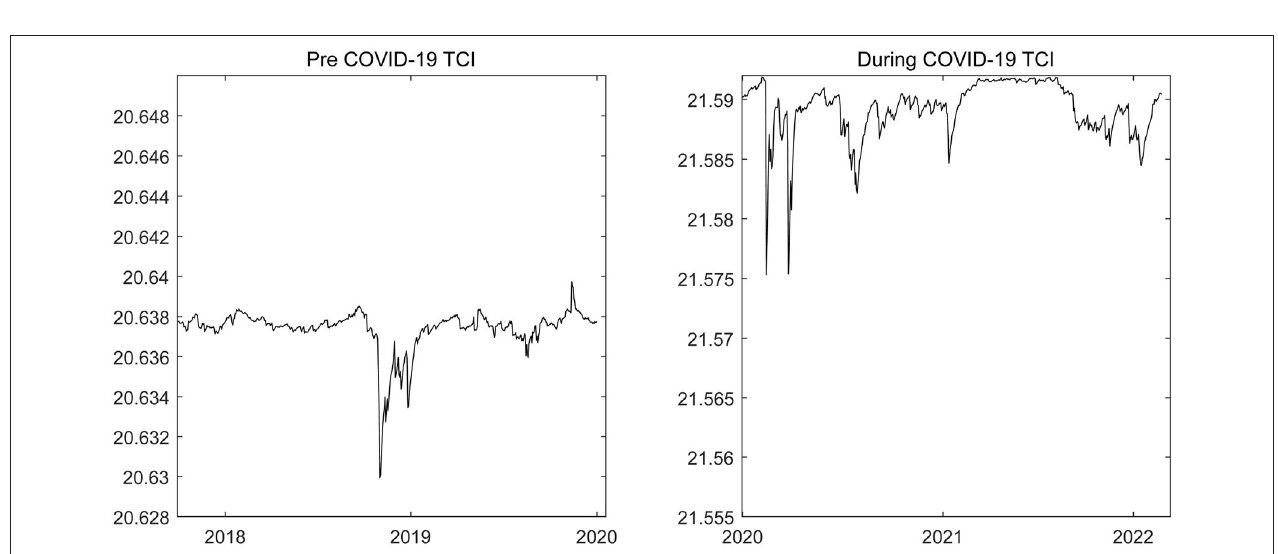
FIGURE 2 | The time-varying total connectedness among energy and precious metals markets. The results are based on the DCC-GARCH-CONNECTEDNESS approach, and the solid line represents the change trend of the total volatility spillover effects of energy and precious metals markets.